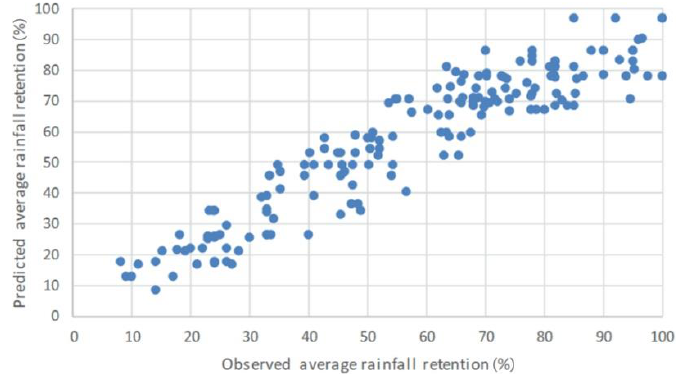
Figure 4. Model Figure 4. Model Accuracy.